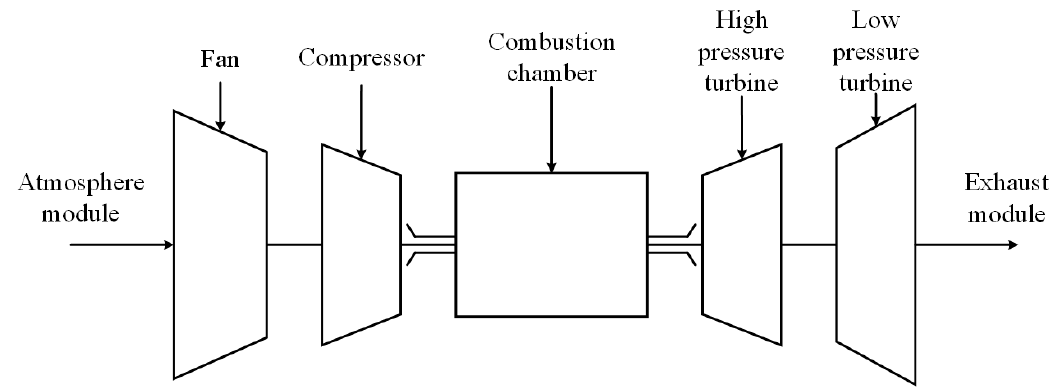
Figure 8. Schematic of a turbofan engine.